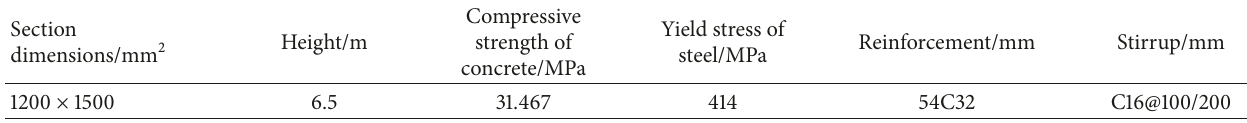
Table 1: Design values of RC pier.